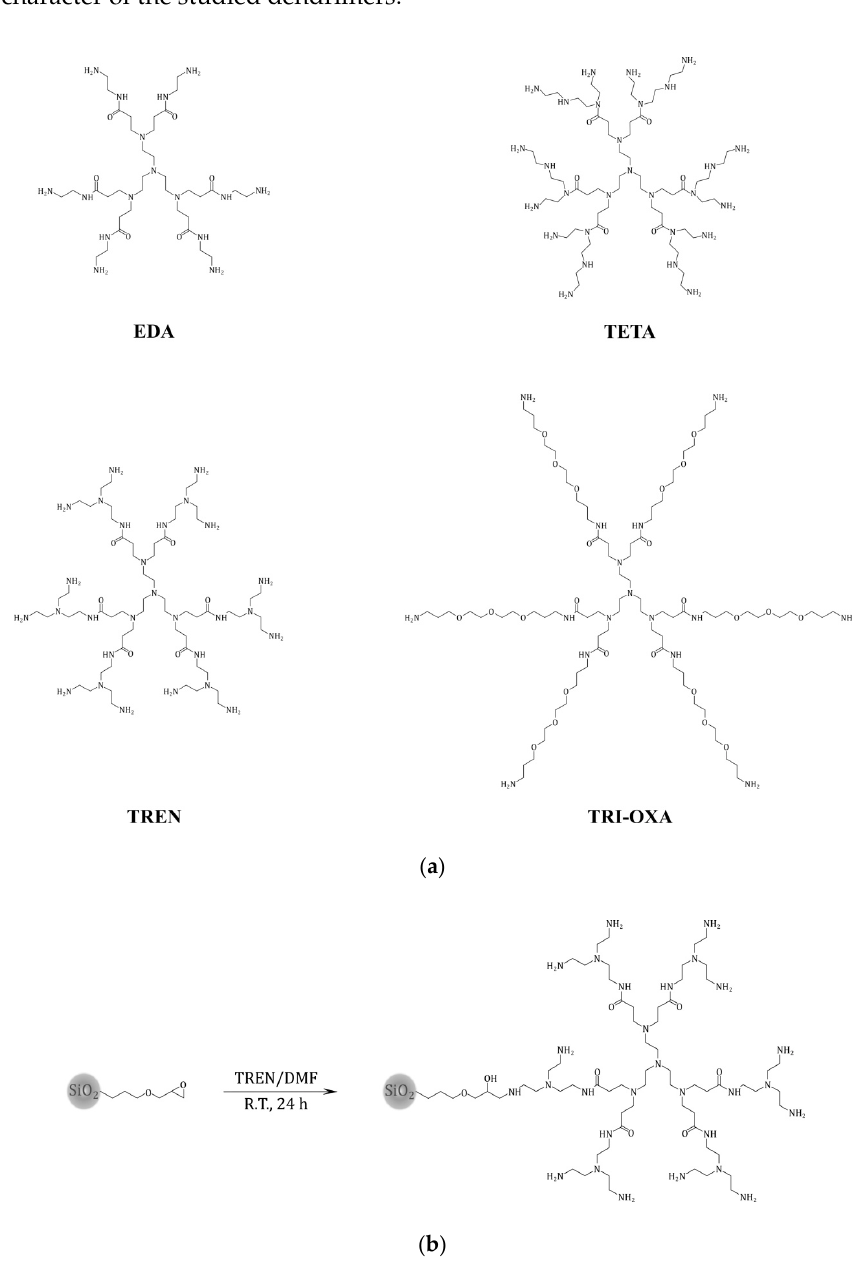
Figure 1. ( a ) The structures of the synthesized poly(amidoamine) (PAMAM) dendrimers containing tris(2-aminoethyl)amine as an amine core and different terminal amino-components: EDA (ethylenediamine), TETA (triethylenetetramine), TREN (tris(2-aminoethyl)amine) and TRI-OXA (4,7,10-trioxa-1,13-tridecanediamine); ( b ) the synthetic approach to obtaining hybrid materials grafted with poly(amidoamine) (PAMAM) dendrimers (on the example of tris(2-aminoethyl)amine (TREN) dendrimer grafting).